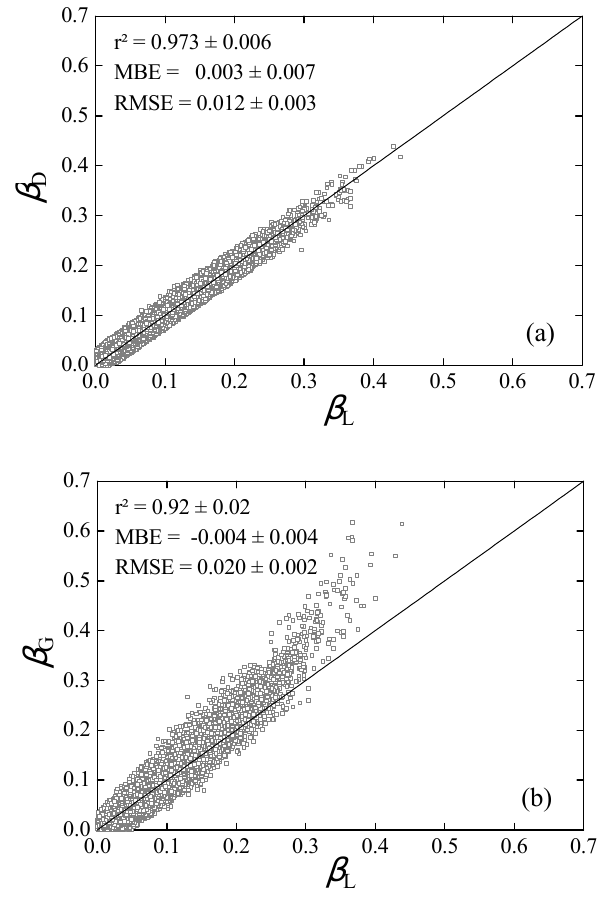
Figure 3 Fig. 3. Comparison between hourly turbidity estimates by using Dogniaux’s, Louche’s and Gueymard’s algorithms.